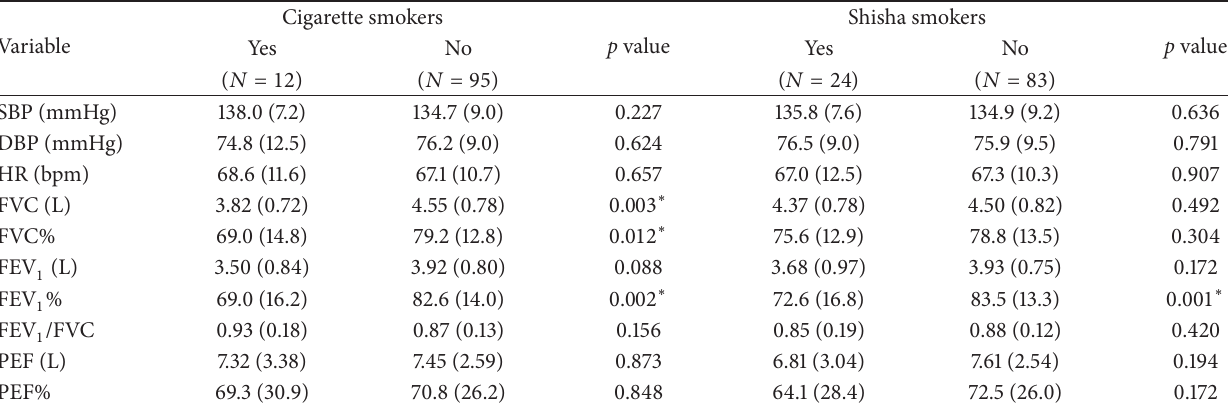
Table 3: Association between tobacco use and health